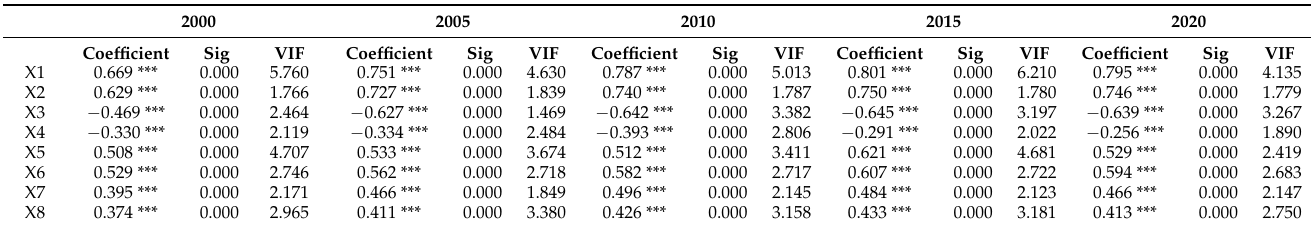
Table 6. Spearman correlation coefficients between RSEI and influencing factors.